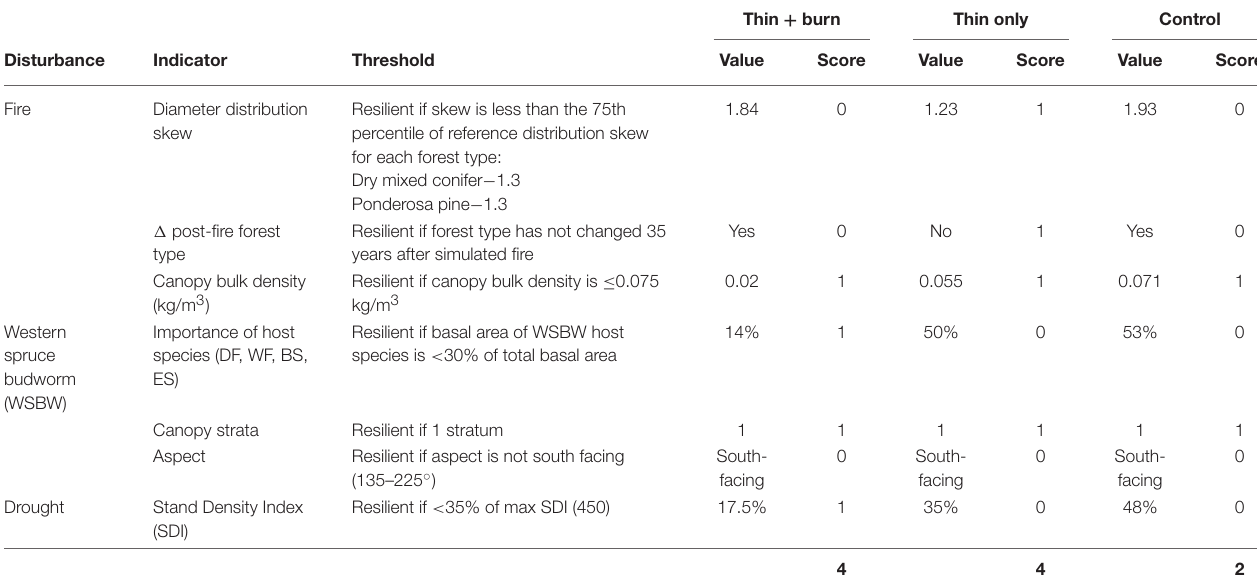
TABLE 4 | Indicator values and overall resilience score in the dry mixed conifer forest type for the thin + burn, thin only, and control treatments on the Lower Middle Mountain Research Project, San Juan National Forest,